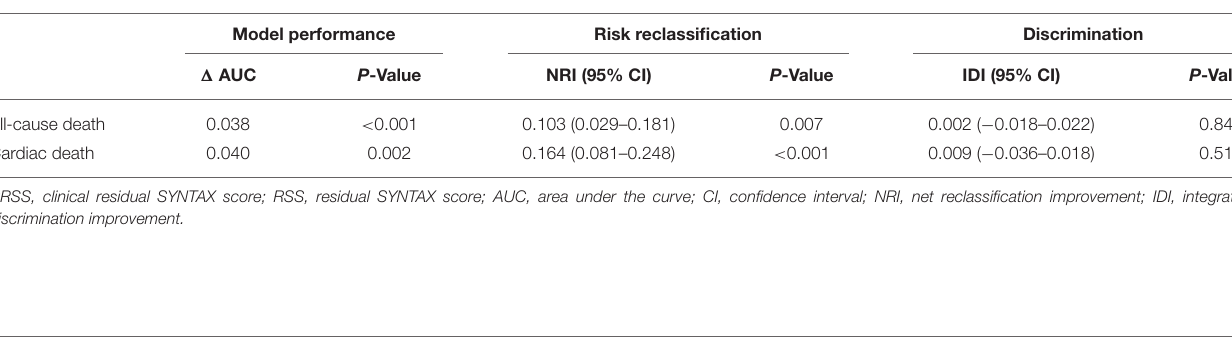
TABLE 6 | Statistics for model improvement of CRSS over RSS for All-cause and cardiac